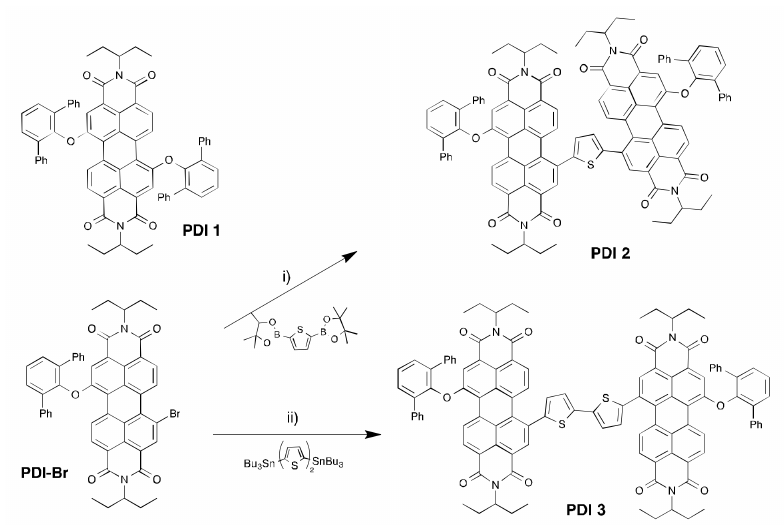
Scheme 1. Chemical structure of PDI 1 and synthesis of PDI 2 and PDI 3. Reaction conditions: